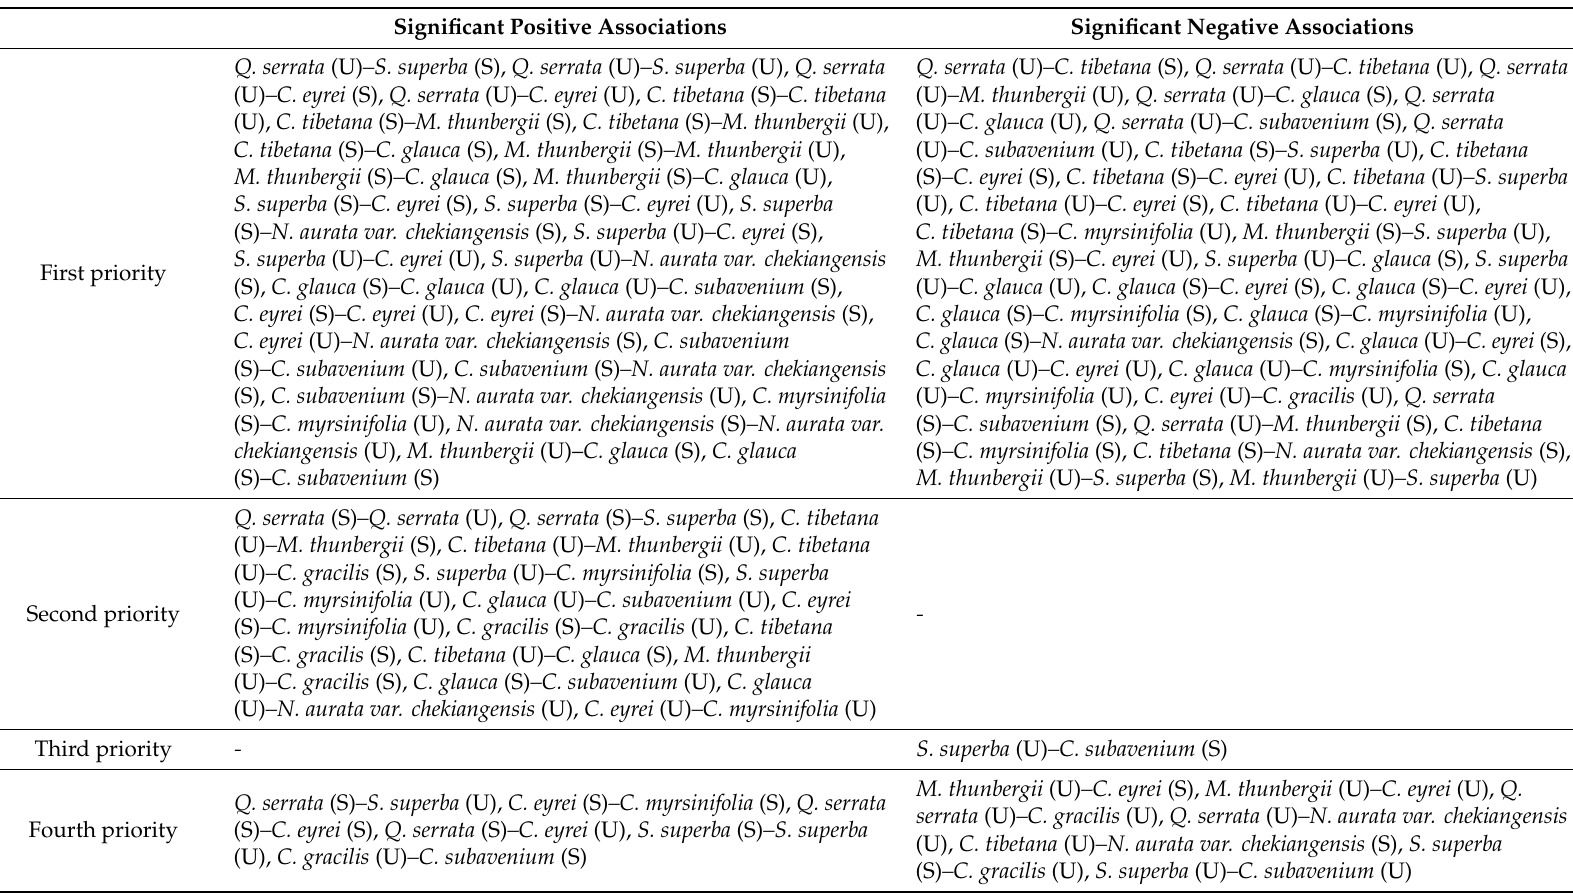
Table 2. The classification of tree species association pairs for the species